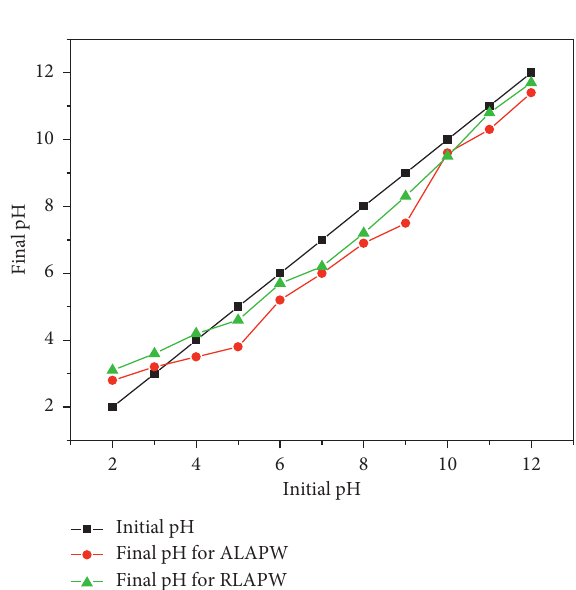
Figure 2: The pHzpc plot of the adsorbents (ALAPW and RLAPW).